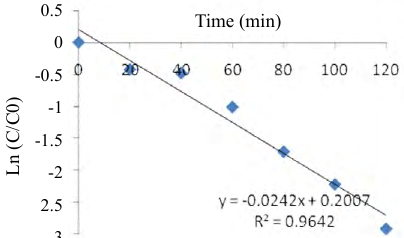
Fig. 11. The effect of amount of loaded amino acid on the conversion (%) of NB (catalyst: 0.1 g,